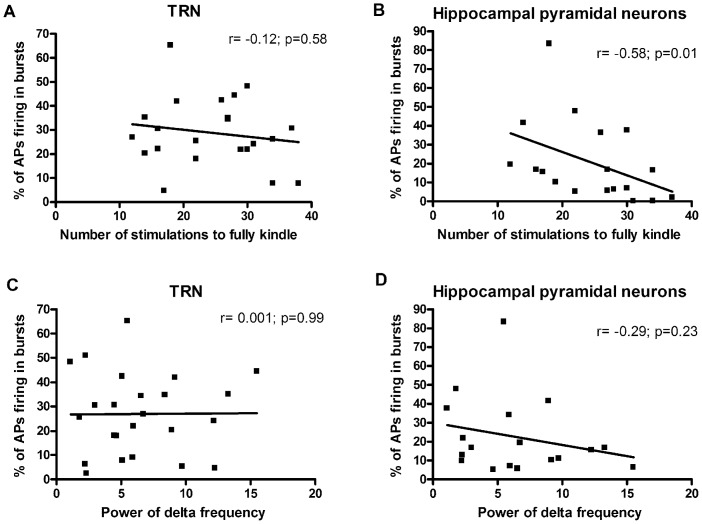
Correlation of burst firing with number of stimulations to reach fully kindled state and power of EEG delta frequency.The number of stimulations required to reach the fully kindled state was not correlated with the percentage of action potentials firing in bursts in the TRN (Spearman r value = −0.12, p = 0.58, A). While in the hippocampus, a significant negative correlation was observed between these two parameters (Spearman r value = −0.58, p = 0.01, B). No significant correlation was observed between the percentage of action potentials firing in bursts and power of EEG delta frequency for either the TRN (Spearman r value = 0.001, p = 0.99, C) or the hippocampus (Spearman r value = −0.29, p = 0.23, D).